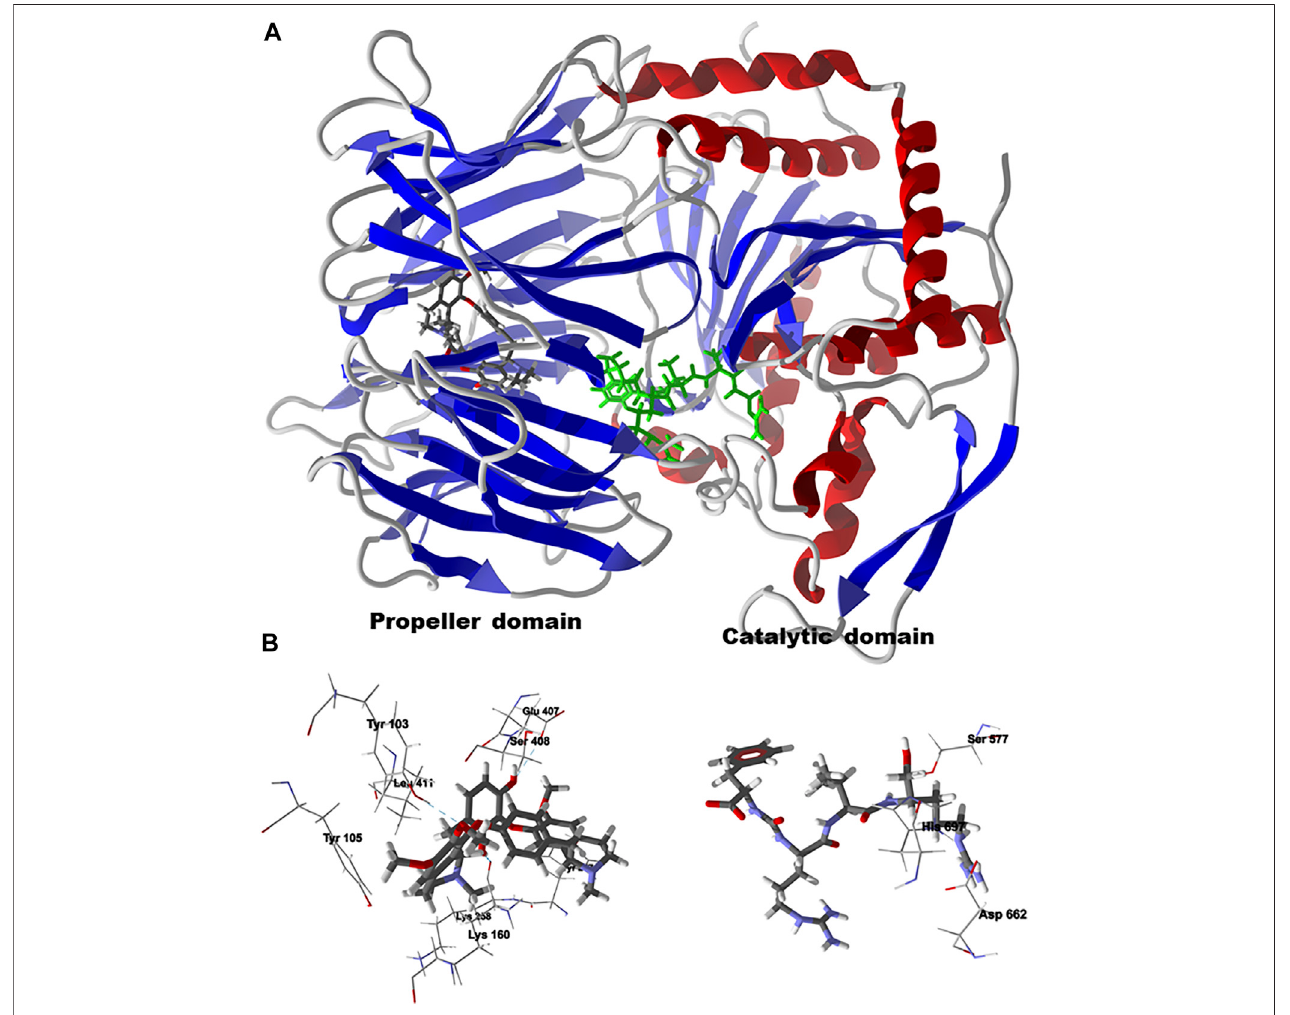
FIGURE 10| Lowest-energydockedposeofchondrofolinolwith Leishmaniamajor oligopeptidaseB(LmajOPB,PDB2XE4). (A) :Ribbonstructure(thedockedchondrofolinol isshownasaCPKstick fi gureandtheco-crystallizedantipainisshownasagreenstick fi gure). (B) :Preferreddockingsiteofchondrofolinolshowingthekeyintermolecularcontacts (hydrogen-bonded interactions are indicated with blue dashed lines); the co-crystallized ligand, antipain, is also shown in the active site along with the catalytic triad.